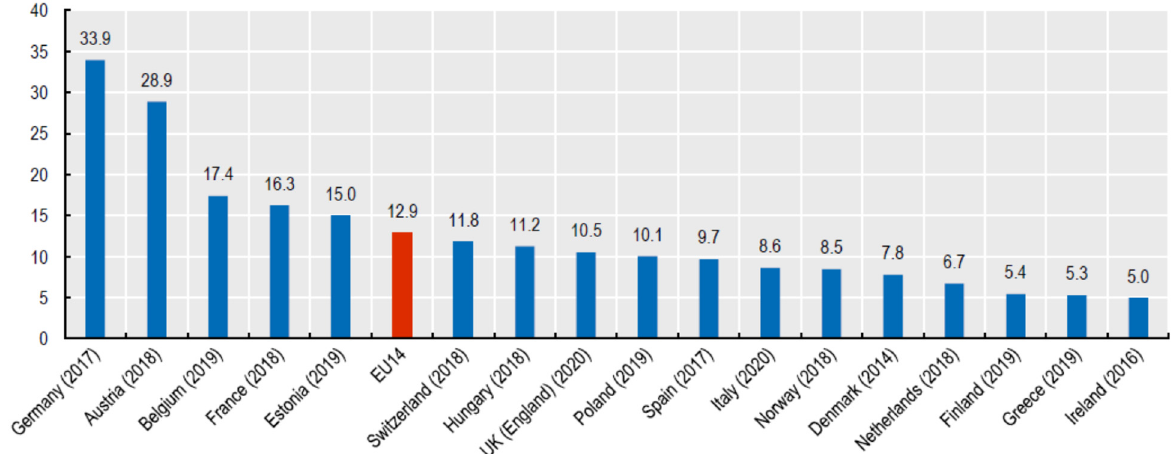
Figure 1. Intensive care capacity—ICU beds before the COVID-19 crisis, latest year available (per 100,000 population), [7].